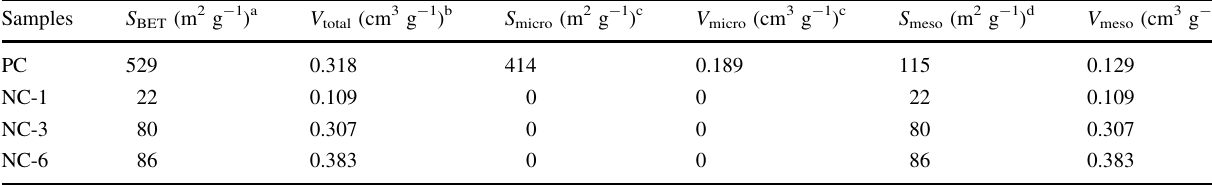
Fig. 5 a N 2 adsorption–desorption isotherms and b the corresponding pore size distribution curves of PC and NC-X samples calculated from the adsorption branches. Solid and empty symbols correspond to the left and right axes, respectively Table 2 Textural properties of pure PC and NC-X samples